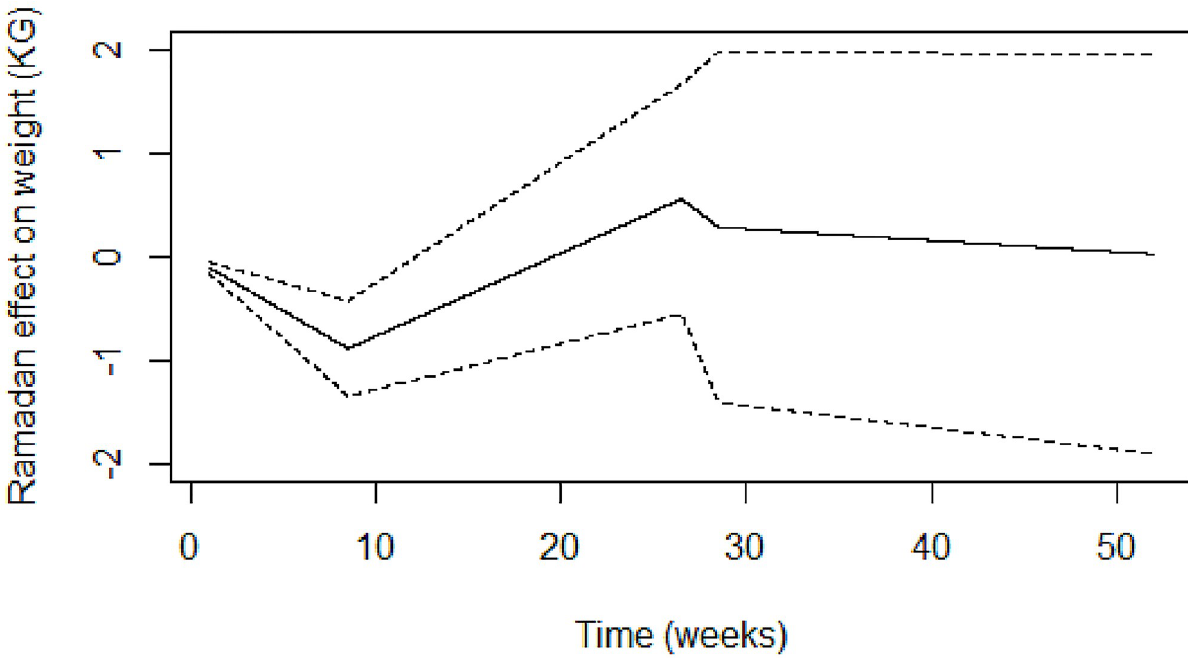
Fig 2. Estimated time-varying effects of Ramadan on weight using the continuous model. Ramadan effect on Weight (kg). Time (weeks).